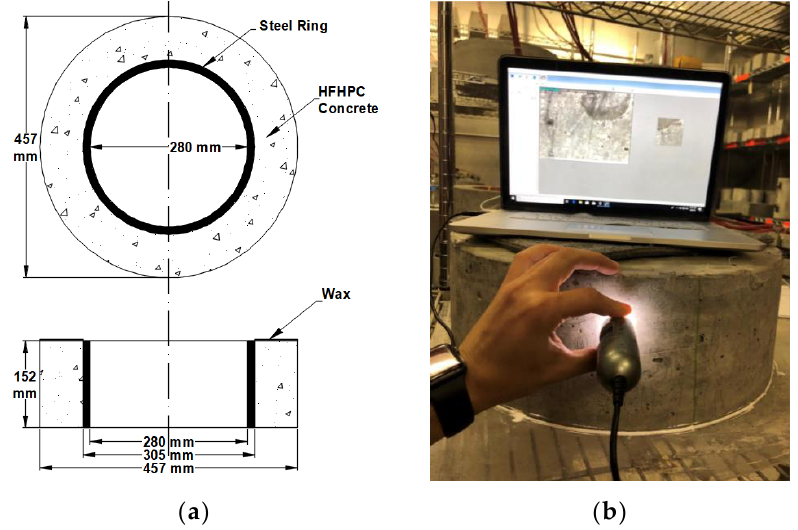
Figure 1. AASHTO PP34 ring test ( a ) dimensions and ( b ) crack mapping process.